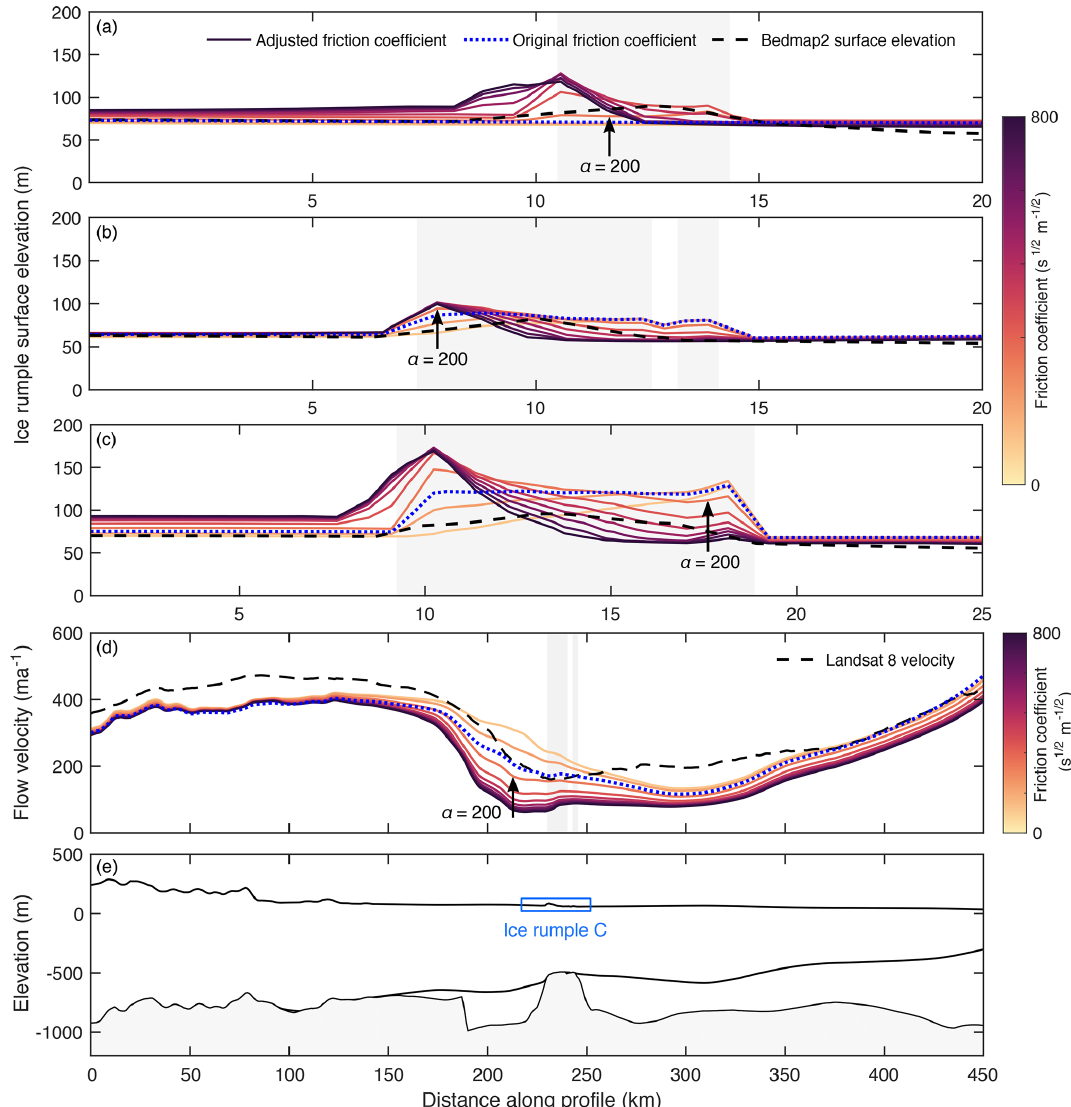
Figure 3. Surface morphology and ice velocity for different basal friction coefficient α values assigned to SCIR model nodes. Along-flow surface elevation profiles in panels (a) , (b) and (c) demonstrate how selection of the friction coefficient before model relaxation affects ice thickness and surface elevation for three ice rumples in the SCIR complex (ice rumples A, B and C, respectively; see Fig. 1b for their location). Grey shaded boxes indicate model nodes where the ice shelf is grounded. Panel (d) demonstrates how selection of the friction coefficient affects the velocity magnitude. The profile in panel (d) represents a single pathway that begins 150km upstream of the MacIS grounding line, intersects the SCIR rumple C and ends at the shelf front. Panel (e) shows ice thickness and the underlying seafloor along this pathway in the reference model. The locations of the profiles in panels (a) to (e) are mapped in Fig.